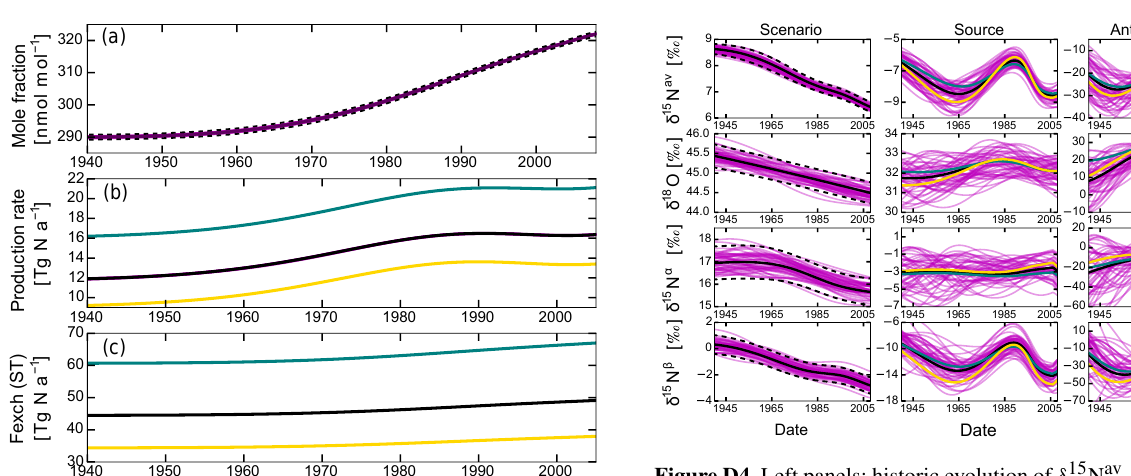
Figure D4. Left panels: historic evolution of δ 15 N av , δ 18 O, δ 15 N α , and δ 15 N β in N 2 O as derived from the firn air reconstruction. The solid black line represents the best-fit scenario, while the dashed ones represent the respective uncertainties as determined by the reconstruction method. Magenta lines represent the emissions that are required to produce the magenta N 2 O histories in the left pan- els. Middle and right panels: isotope signatures of the total emit- ted N 2 O and anthropogenic source, respectively, assuming high (0.28Tmols − 1 ) F exch in light green and a low (0.16Tmols − 1 ) value in yellow. The solid black line represents the result for the best-fit reconstruction, while magenta lines represent the results for the individual scenarios from the top as used in the main paper. F exch choice has little effect on the isotopic signature